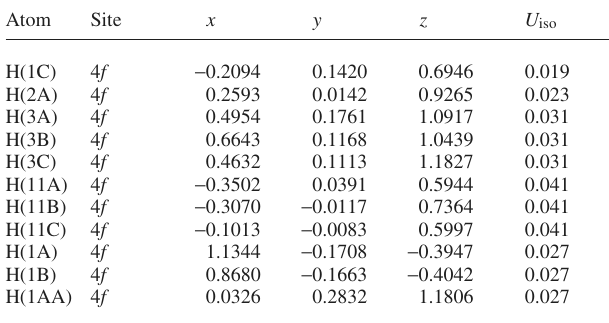
Table 2. Atomic coordinates and displacement parameters (in Å 2 ) .